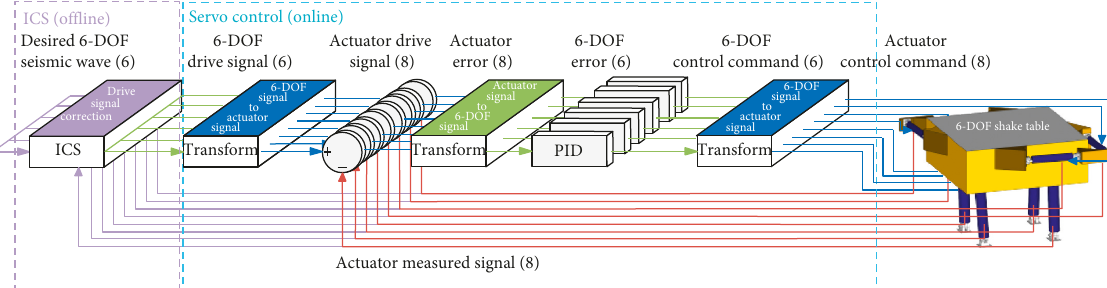
Figure 2: The control system of the shake table at Central South University.